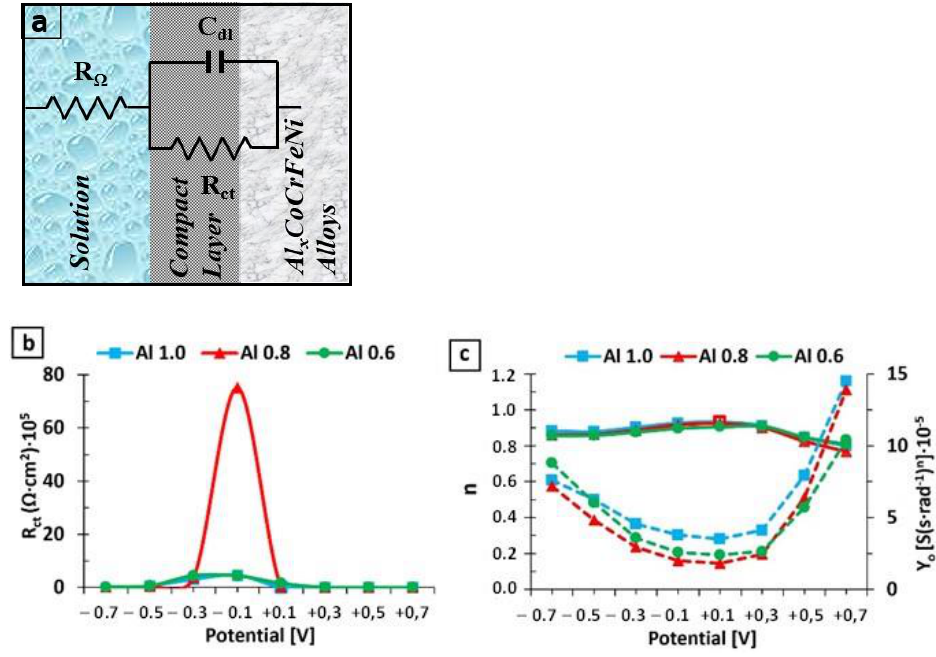
Figure 7. ( a ) Simple equivalent circuit used for the fitting; ( b ) R ct evolution with the potential; ( c ) Y 0 and n parameter corresponding to C dl for the studied alloys.